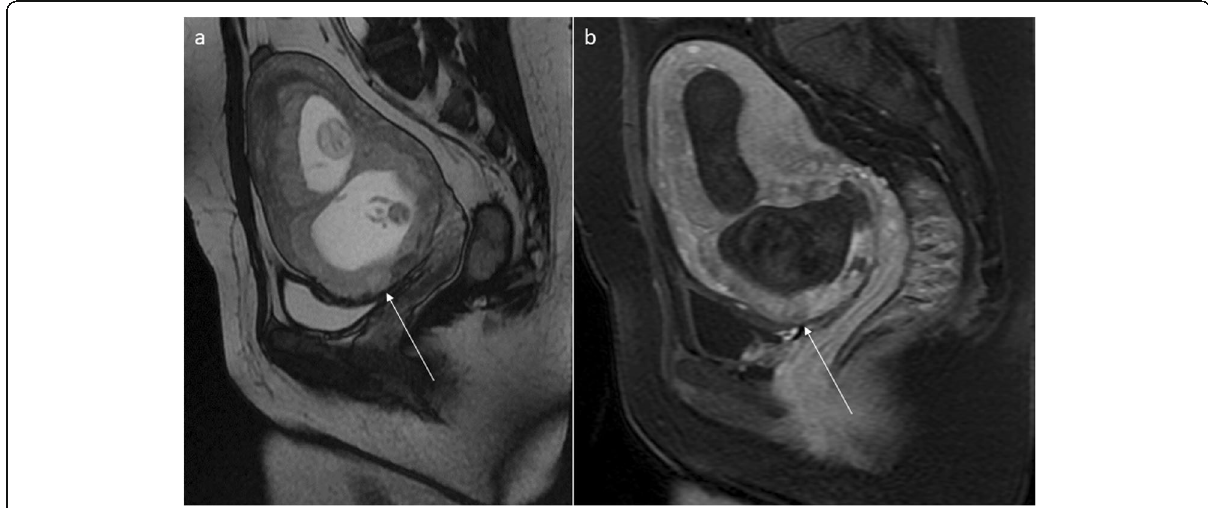
Fig. 14 A 34-year-old woman, 4th pregnancy, dichorionic, diamniotic, 11 GW, history of 2 C-sections. FIESTA/2D image ( a ) and dynamic contrast- enhanced fat-saturated T1 sequence after gadolinium administration ( b ), both in sagittal projection, show placenta increta in the post-C-section scar. The urinary bladder did not show abnormalities on